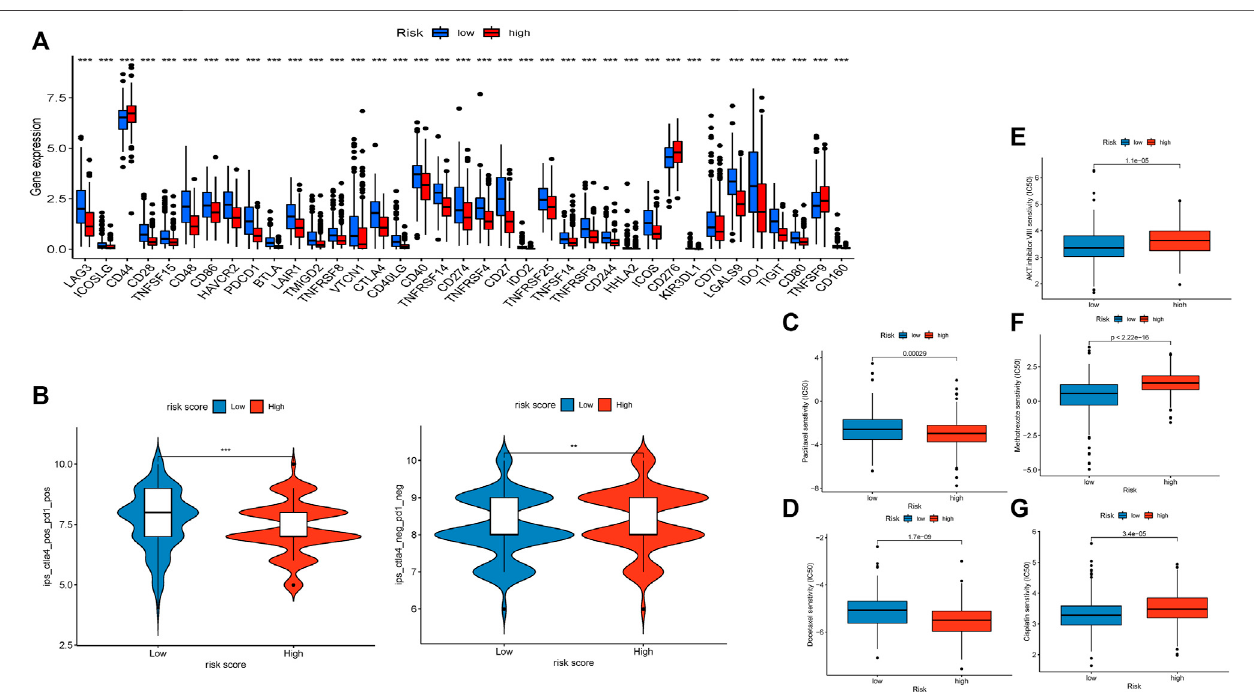
FIGURE 6 | Evaluation of immunotherapy and sensitivity of commonly used chemotherapeutic drugs. (A) . Boxplot showing the gene expression of 37 immune checkpoint genes. (B) . Violin diagram visualizing the response to anti-CTLA4 and anti-PD-1 therapies between the two groups. (C) . Boxplot demonstrating the IC50 of paclitaxel. (D) . Boxplot demonstrating the IC50 of docetaxel. (E) . Boxplot demonstrating the IC50 of the AKT inhibitor VIII. (F) . Boxplot demonstrating the IC50 of docetaxel. (G) . Boxplot demonstrating the IC50 of cisplatin.